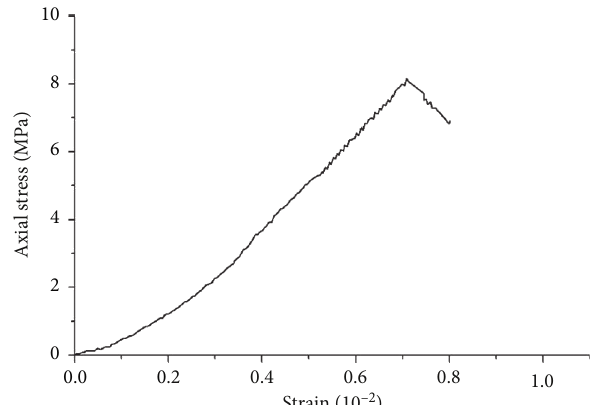
Figure 10: Stress–strain curve of uniaxial compression test of backfill.